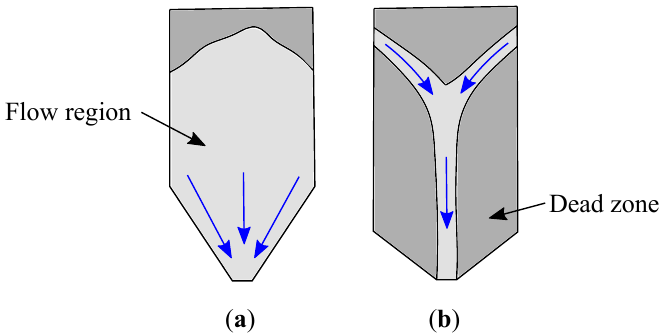
Figure 10. Hopper emptying mechanisms: ( a ) mass flow and ( b ) funnel flow.